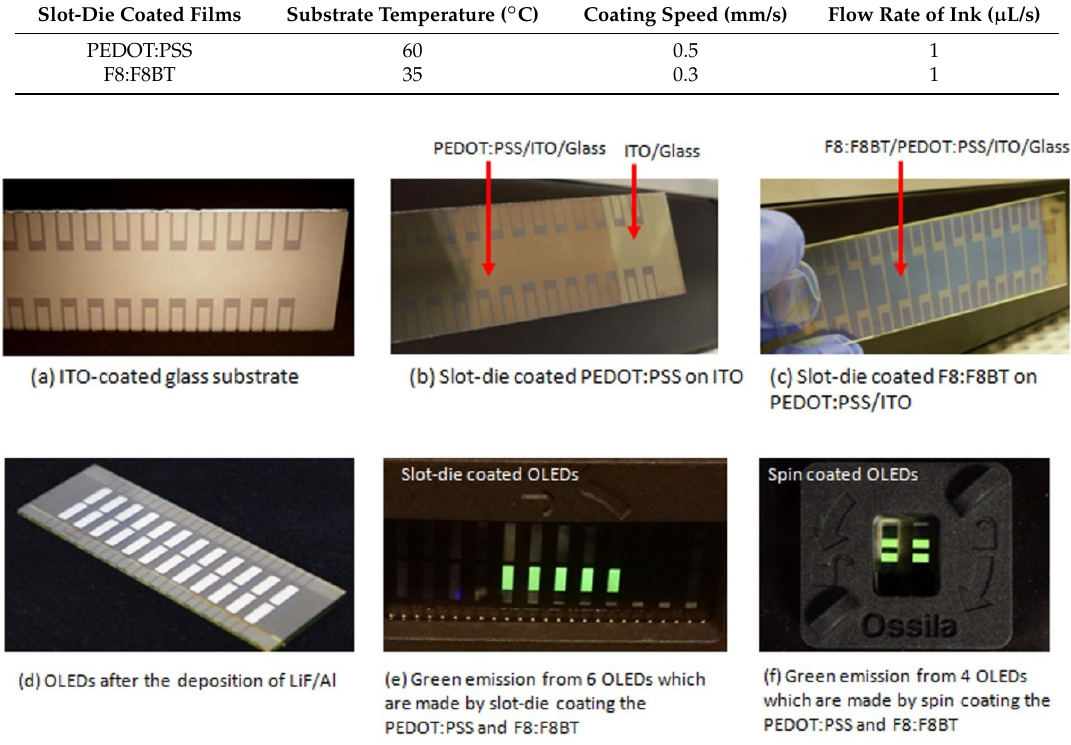
Figure 2. Pictures of: ( a ) indium-tin-oxide (ITO) coated glass substrates after UV-ozone cleaning, ( b ) poly(3,4-ethylenedioxythiophene) polystyrene sulfonate (PEDOT:PSS) film coated using slot-die coater, ( c ) slot-die coated poly(9,9-dioctylfluorene): poly(9,9-dioctylfluorene-alt-benzothiadiazole) (F8:F8BT) film coated on top of PEDOT:PSS layer, ( d ) 24 pixels of organic light emitting diodes (OLEDs) after the deposition of cathode, ( e ) uniform light emission from the slot-die coated OLEDs, and ( f ) uniform light emission from the spin-coated OLEDs.